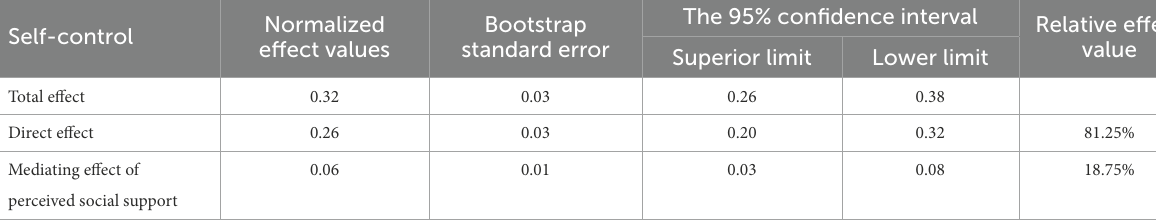
TABLE 3 Decomposition table of the mediating role of perceived social support.